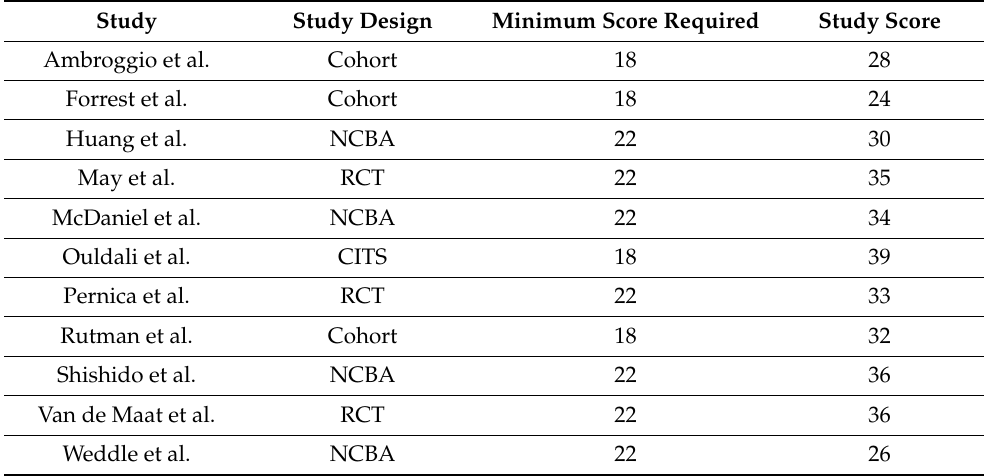
Table A4. Score Attributed to Included Articles. Paediatric Antimicrobial Stewardship for Respiratory Infections in the Emergency Setting: A Systematic